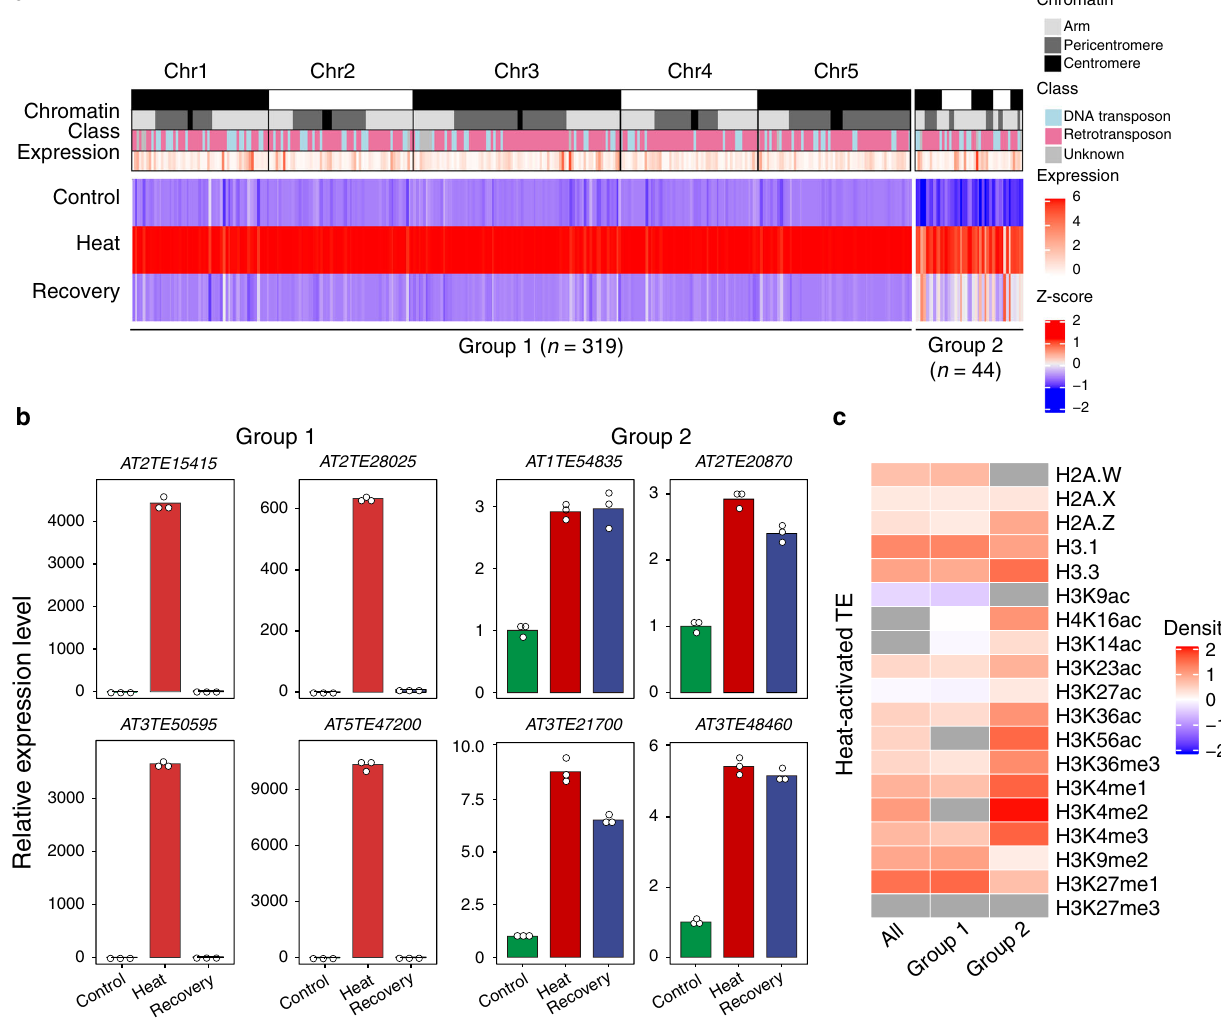
Fig. 2 Characterization of two groups of heat-activated TEs. a Heatmap of heat-activated TEs in Control, Heat, and Recovery. The chromatin track shows the genomic locations of heat-activated TEs. The class track shows the three classes of the heat-activated TEs. The expression track shows the expression levels of heat-activated TEs in log 2 (CPM + 1). The bottom three tracks show relative expression levels ( Z -scores) for Control, Heat, and Recovery and range from − 2 (blue) to 2 (red). Most heat-activated TEs, classi fi ed into Group 1, are silenced again during recovery. Some heat-activated TEs, classi fi ed into Group 2, exhibited persistent activation or were not completely restored during recovery. b Expression dynamics of randomly selected Group 1 and Group 2 TEs as determined by RT-qPCR. The expression value of each replicate was normalized to the expression level of Col-0. Circles denote relative expression values. Bars indicate mean values of three technical replicates. c The enrichment (red) and depletion (blue) patterns of epigenetic features in Group 1 and Group 2 TEs compared with total TEs in Arabidopsis . Relative density ranges from − 2 to 2. Gray indicates that the epigenetic feature is neither enriched nor depleted (two-sided Mann – Whitney U test, p > 0.05). Source data underlying b and c are provided as a Source Data fi